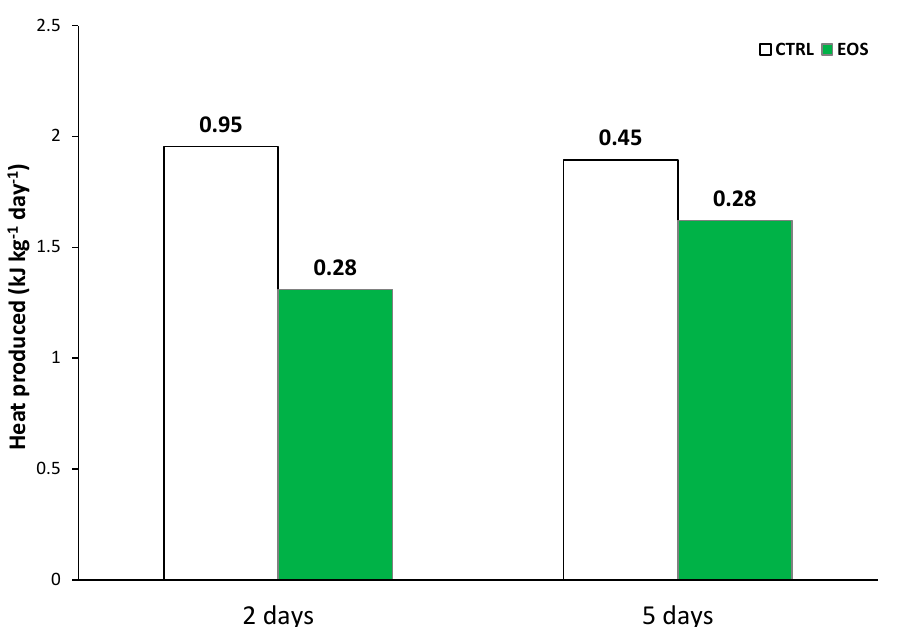
Figure 11. Heat production related to the respiration of flat peaches after 2 and 5 days at 8 ◦ C. Heat production is calculated according to Equation (1) and from data previously published [43]. The numbers on the bars are the ethylene production rate (nmol kg − 1 h − 1 ).